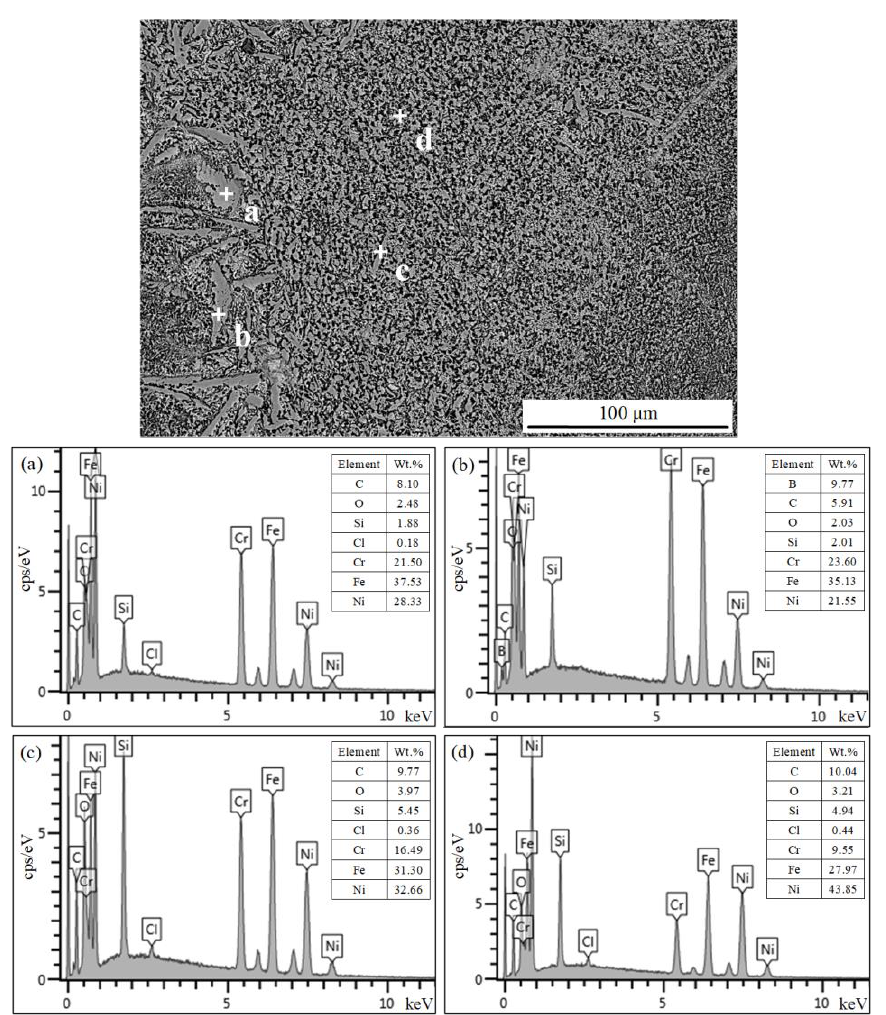
Figure 10. The analysis results of the energy dispersive spectrometer of the cladding layer. ( a ) EDS analysis of point a ; ( b ) EDS analysis of point b ; ( c ) EDS analysis of point c ; ( d ) EDS analysis of point d .